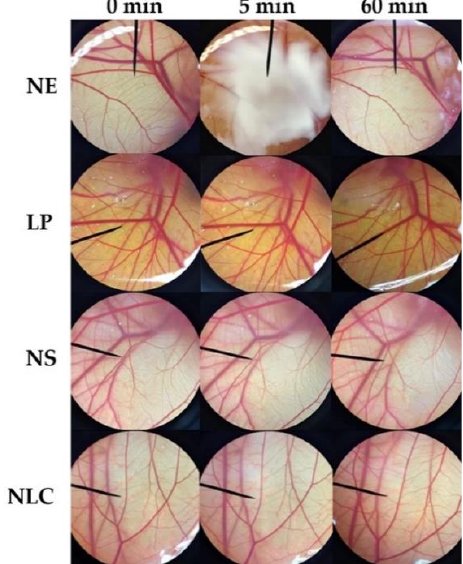
Figure 8. Photographs illustrating the effect of nanoemulsion (NE), liposome (LP), niosome (NS), and nanostructured lipid carriers (NLC) on chorioallantoic membrane before exposure the sample (0 min), after 5 min, and at the end of the experiment of 60 min.